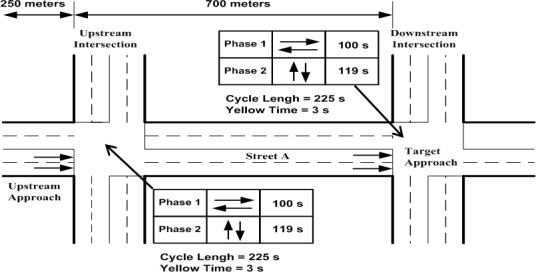
Test intersection.